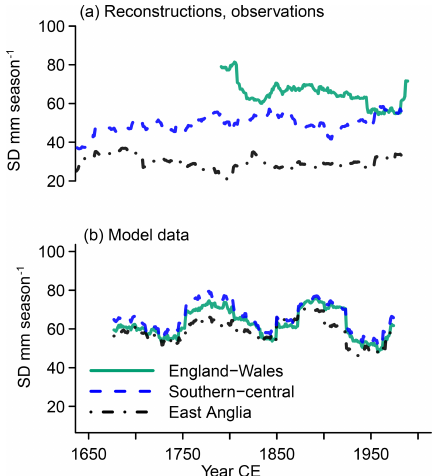
Figure 6. Visualization of Weibull standard deviations (SDs) over 51-year windows for MAMJJ precipitation for England–Wales (green solid lines), southern–central England (blue dashed lines), and East Anglia (black dash-dotted lines) in (a) reconstructions, ob- servations, and (b)